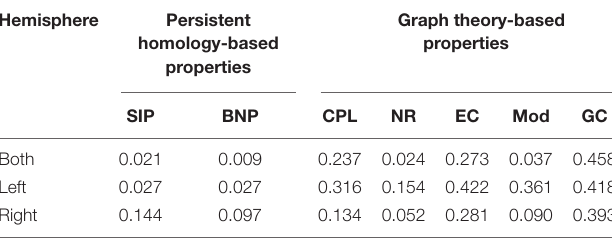
TABLE 3 | Statistical p -values of different network properties between APOE4 + and APOE4- groups.